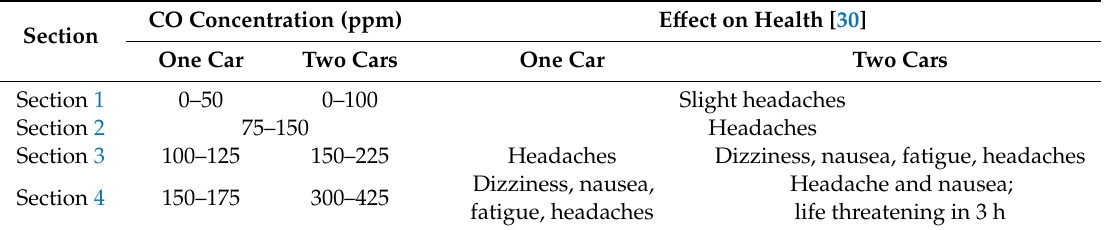
Table 6. Carbon-monoxide concentration at the major change periods, and influences on the body based on